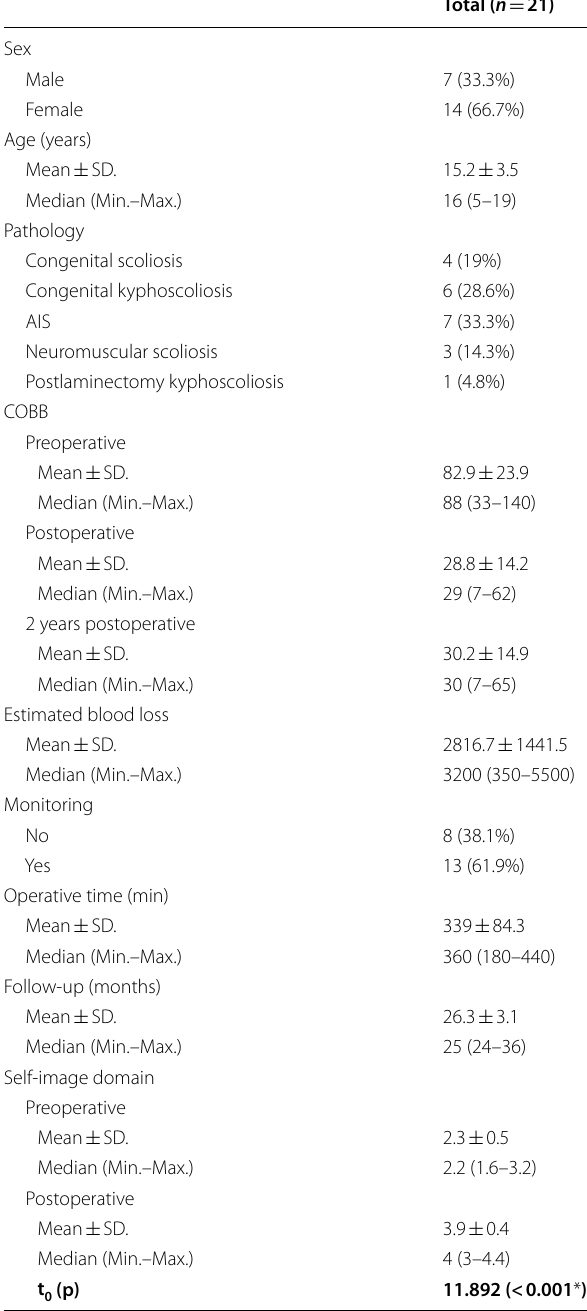
Table 2 Statistical analysis of the epidemiological and